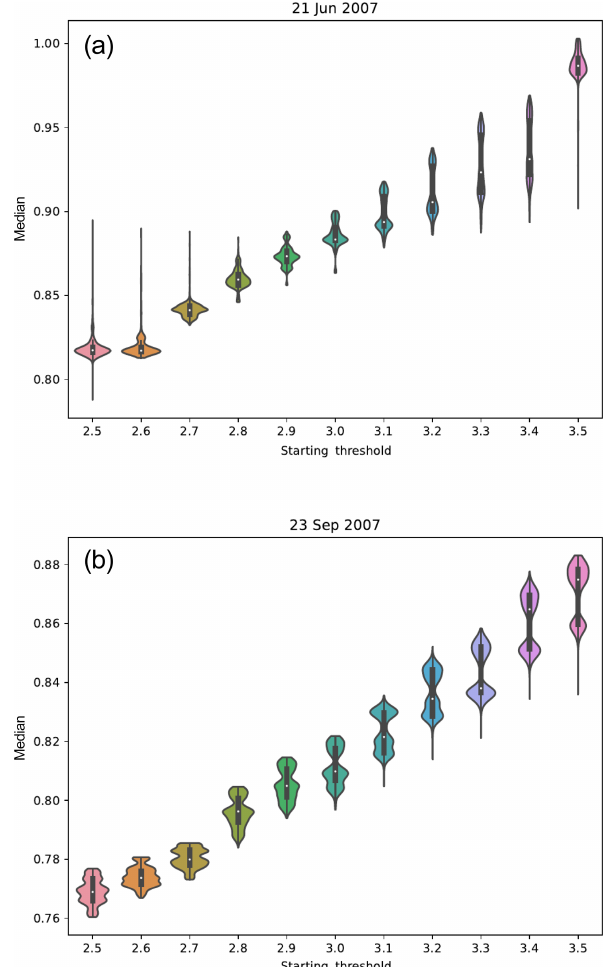
Figure 6. Violin plots show the effect of starting threshold on vari- ance of errors: summer solstice (a) and autumn equinox (b) . Figure 7. Violin plots show the effect of starting threshold on error distribution medians: summer solstice (a) and autumn equinox (b)